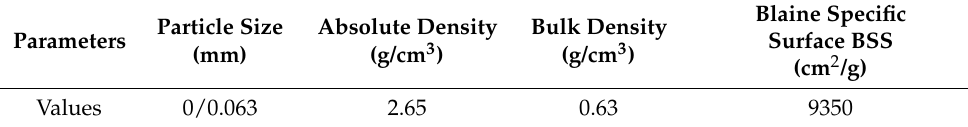
Table 4. Physical parameters of marble powder.